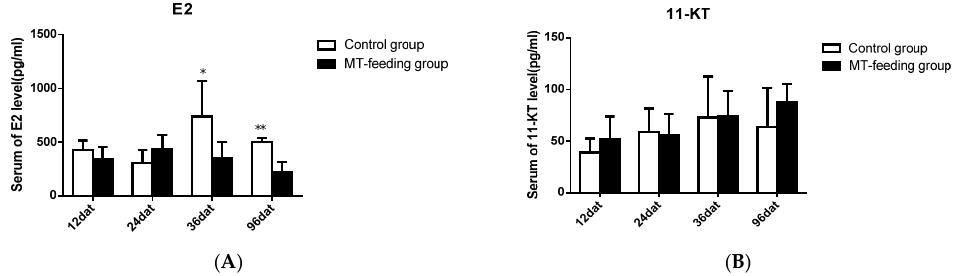
Figure 3. Serum E2 and 11-KT level during MT-induced sex reversal. ( A ) The E2 level in the control and MT-feeding group. ( B ) The 11-KT level in the control and MT-feeding group. Data are expressed as the mean ± SD for five fish. * and ** represent significant difference at p < 0.05 and p < 0.01 between the control group and MT-feeding group.